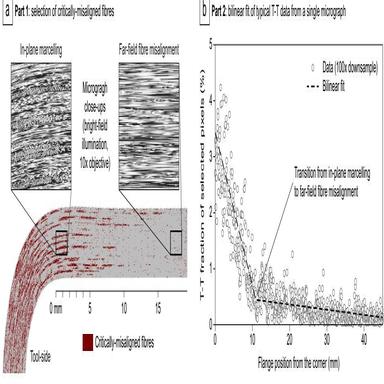
Illustration of the determination of fibre waviness extent into flanges: (a) Part 1: selection of critically-misaligned fibres in corner-flange micrographs; (b) Part 2: bilinear fit of T-T data from a single micrograph.